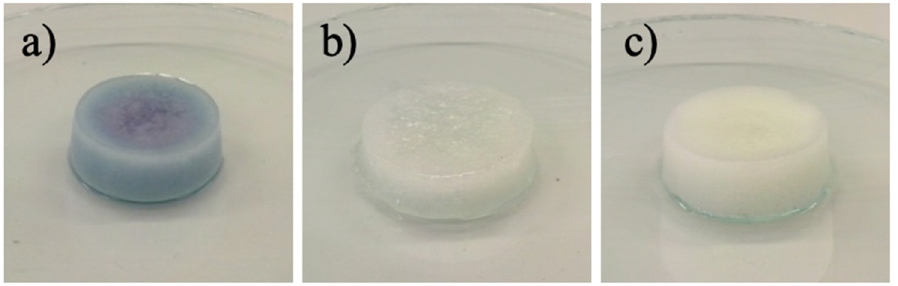
Figure 8. Photographs of the GS 2:1 hybrids after adsorption of metal ions: ( a ) copper(II), ( b ) lead(II), ( c ) cadmium(II).